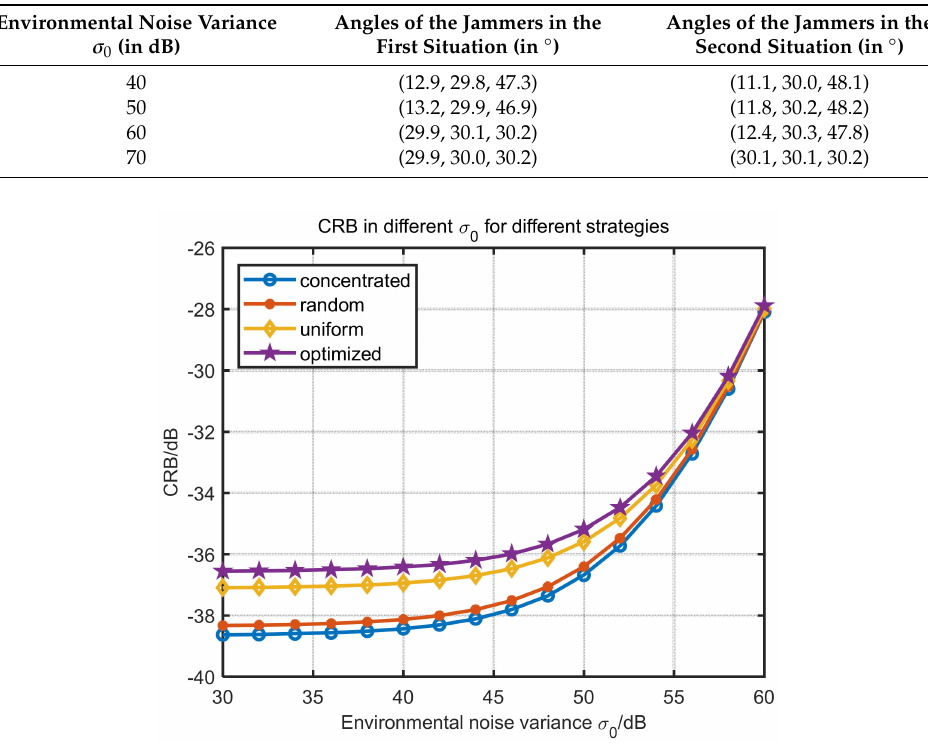
Figure 5. Cram é r–Rao bound (CRB) under environmental noise with di ff erent variances for di ff erent strategies in a single-target